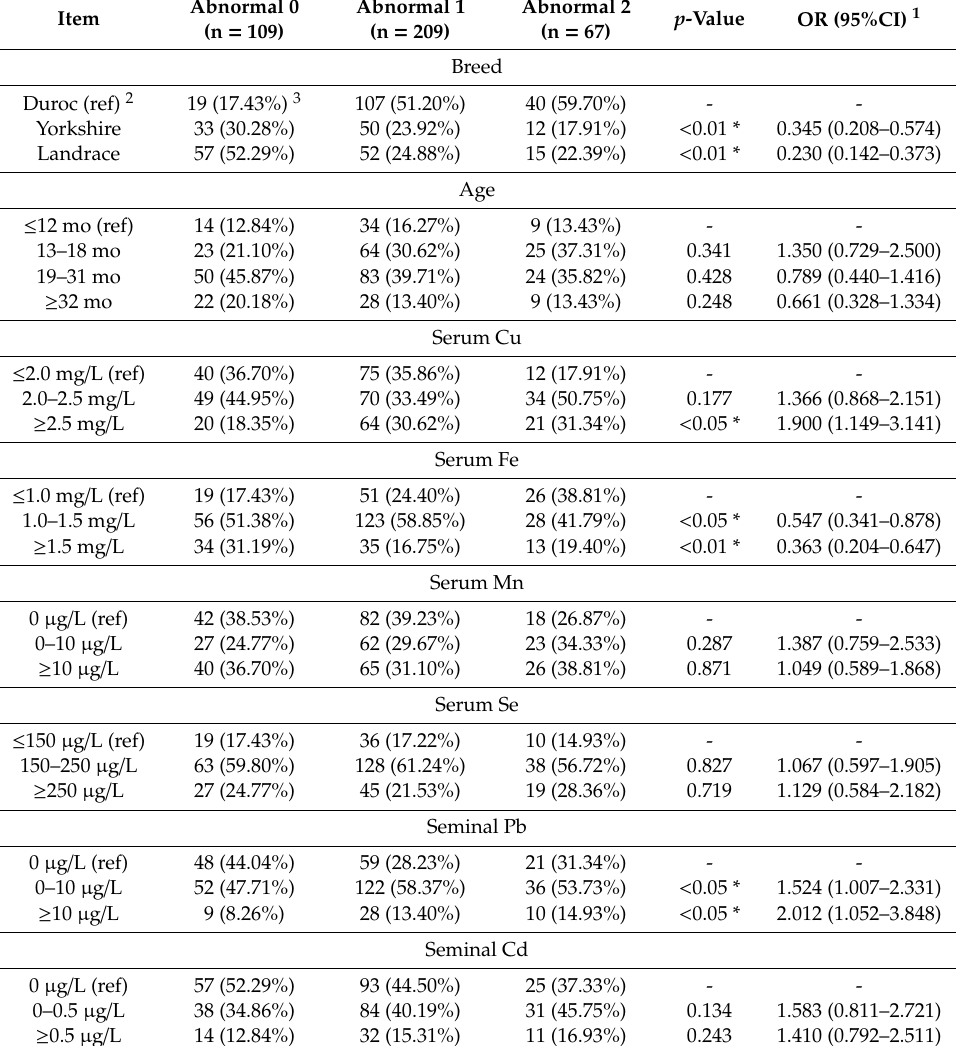
Table 4. The potential influencing factors and univariate analysis results of the abnormal sperm morphology (n =